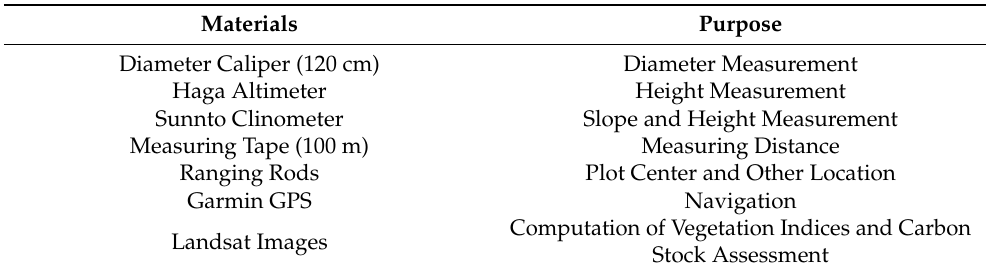
Table 1. Tools used in field